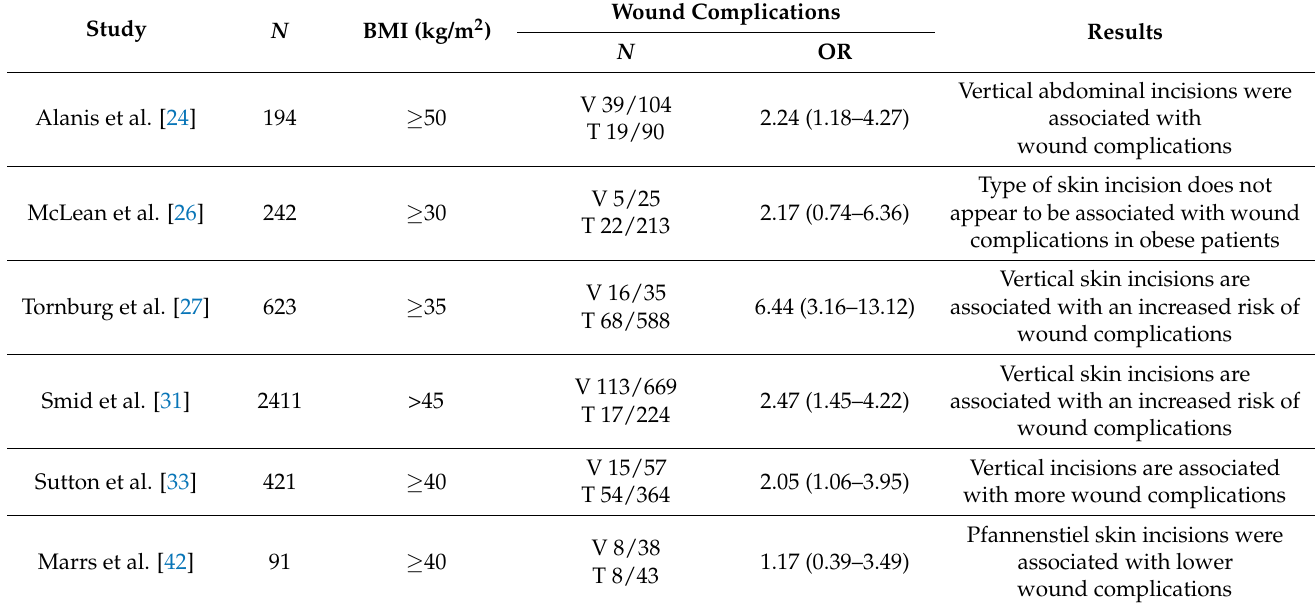
Table 4. Types of skin incisions and wound